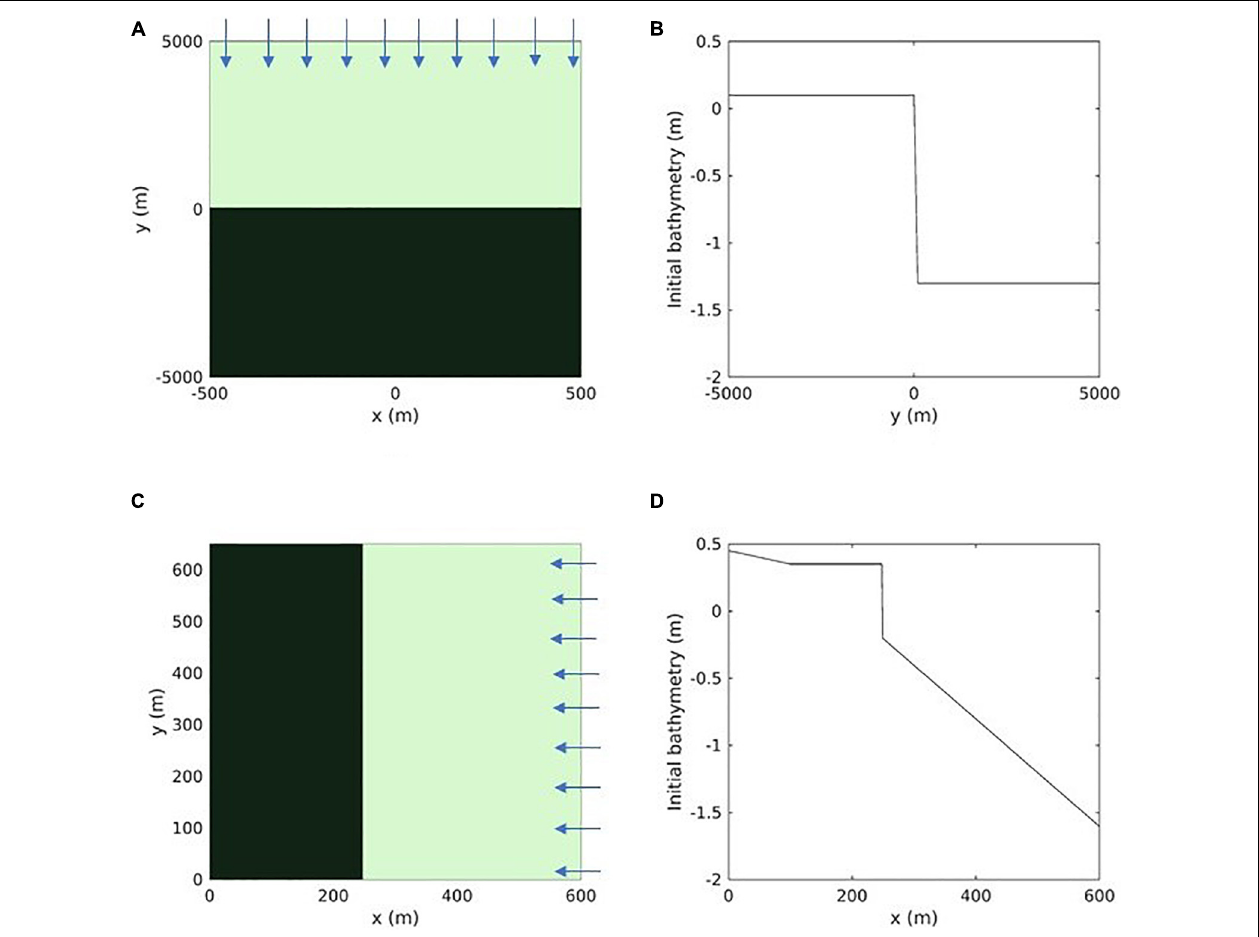
FIGURE 2 | Idealized case to formulate lateral wave thrust: (A) Planform view and, (B) Initial bathymetry for 100 m resolution domain. High resolution idealized case to test the marsh lateral retreat formulations: (C) Planform view and, (D) Initial bathymetry for 1 m resolution domain. Estuary and marsh coverage are shown by light and dark green colors, respectively, in the planform view and arrows point toward the direction of hydrodynamic forcing.